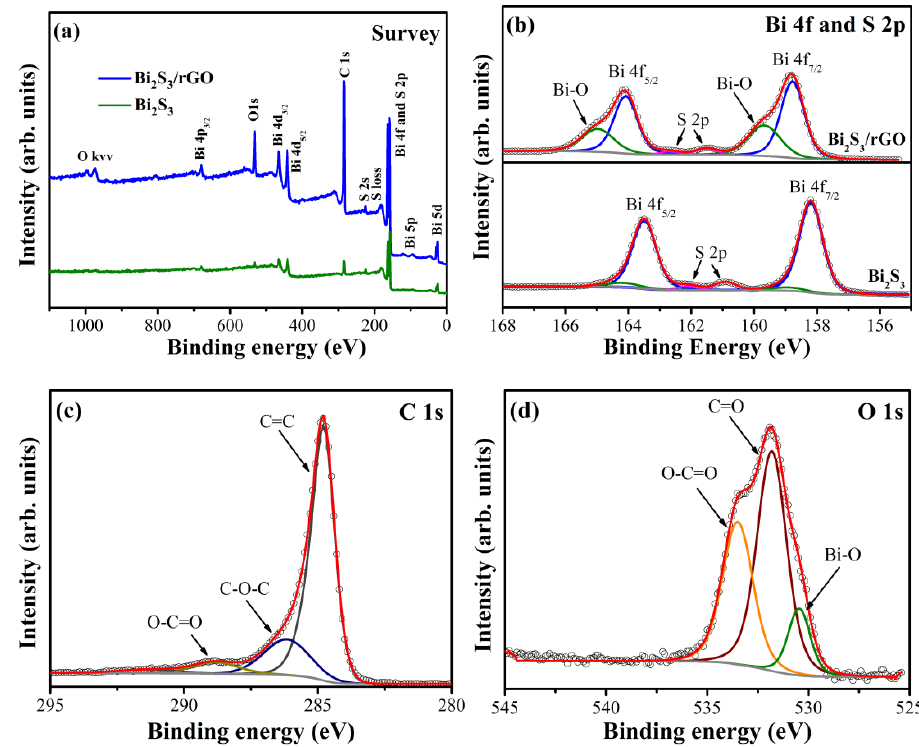
Figure 3. XPS survey spectra of ( a ) Bi 2 S 3 , and Bi 2 S 3 /rGO-3 and core-level XPS spectra of ( b ) Bi 4f and S 2p, ( c ) C1s, ( d ) O1s in Bi 2 S 3 /rGO-3.